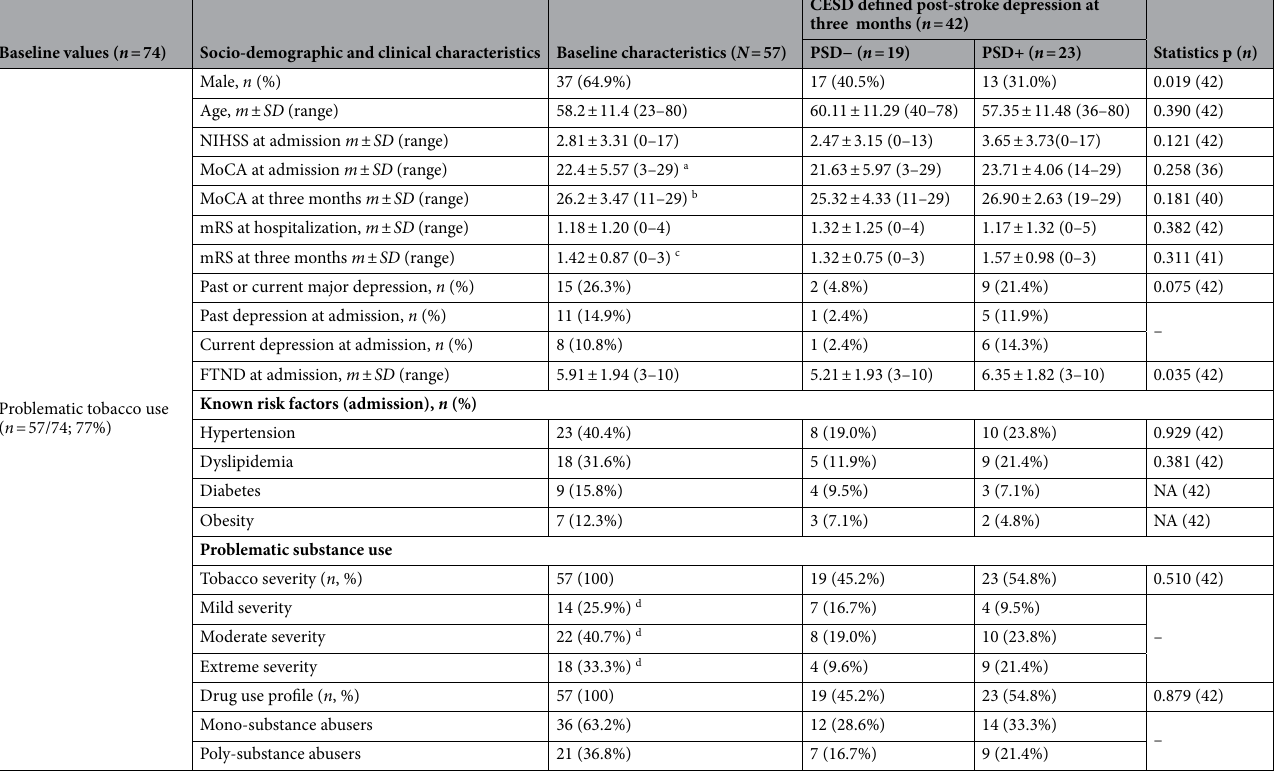
Table 2. Characteristics of the sub-group of patients with a problematic substance use. CESD Center of Epidemiological Studies Depression scale, FTND Fagerström Test for Nicotine Dependence, AUDIT Alcohol Use Disorders Identification Test, CAST Cannabis Abuse Screening Test, MoCA Montreal Cognitive Impairment, mRS modified Rankin Scale, NIHSS National Institutes of Health Stroke Scale, PSD + Sub-group of patients with CESD score indexing a moderate or severe depression, PSD − Sub-group of patients with CESD score indexing no depression. a ( n = 48); b ( n = 44); c ( n = 45); d ( n =